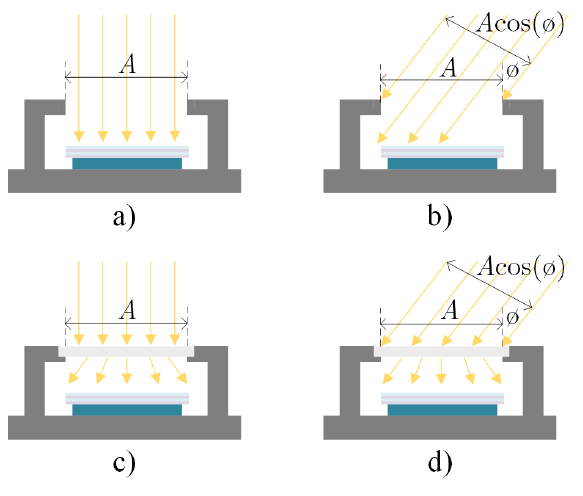
Fig. 8. Cross-sectional diagram of a sensor with and without a diffuser. a) sensor without diffuser and normal incidence; b) sensor without diffuser and oblique incidence; c) sensor with diffuser and normal incidence; d) sensor with diffuser and oblique